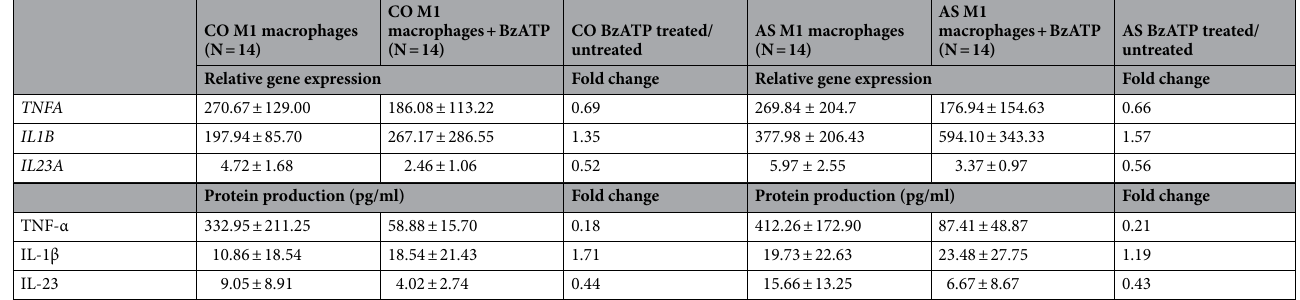
Table 3. The mRNA expression and protein production of IL-23, IL-1β, and TNF-α pro-inflammatory cytokines in M1 macrophages from AS patients and healthy controls before and after BzATP treatment. Data are presented as mean ± SD. AS ankylosing spondylitis; CO controls; TNF-α tumor necrosis factor-alpha, IL-1β interleukin 1 beta, IL-23 Interleukin-23.